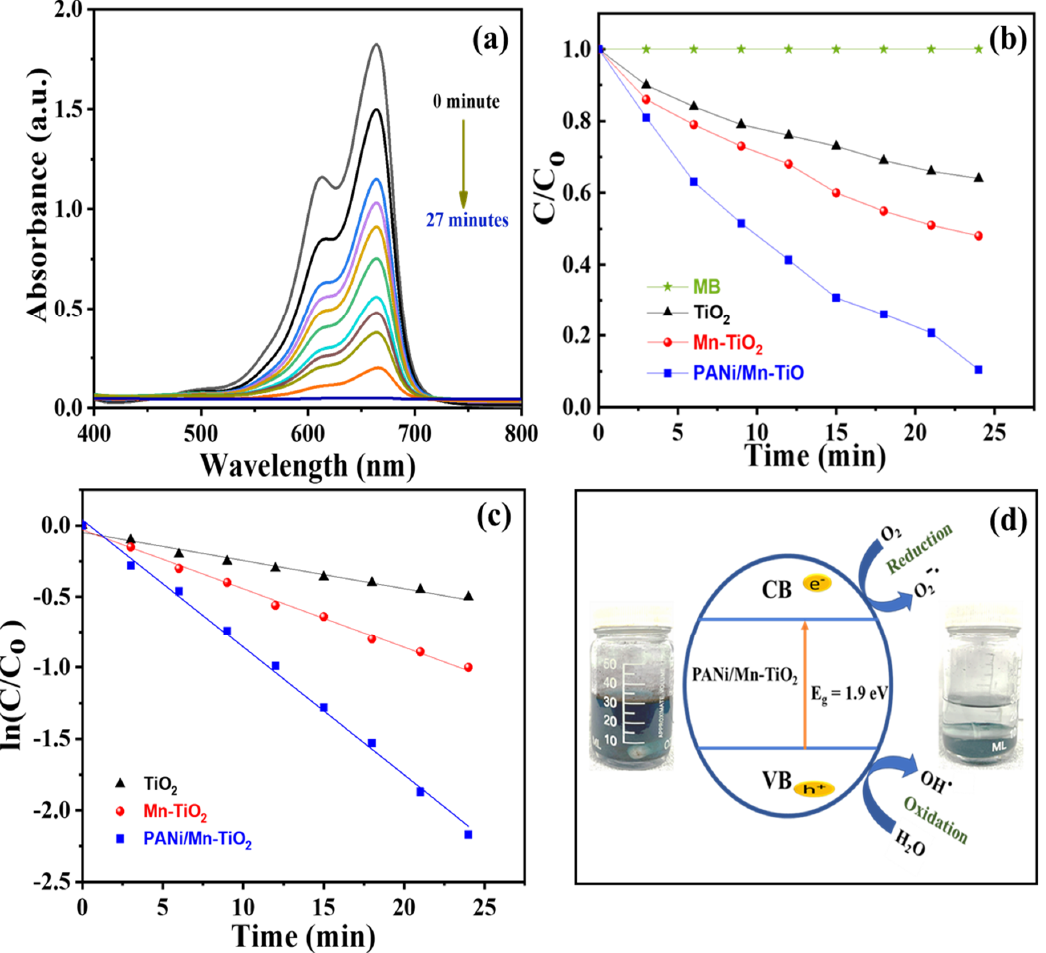
Figure 7. Photocatalytic activity, ( a ) absorbance spectra of the MB by PANi/Mn-TiO 2 , ( b ) degradation of MB by different samples, ( c ) kinetic curves of studied photocatalyst, ( d ) schematic illustration of photocatalysis mechanism of PANi/Mn-TiO 2 composite catalyst for MB degradation under visible light irradiation.